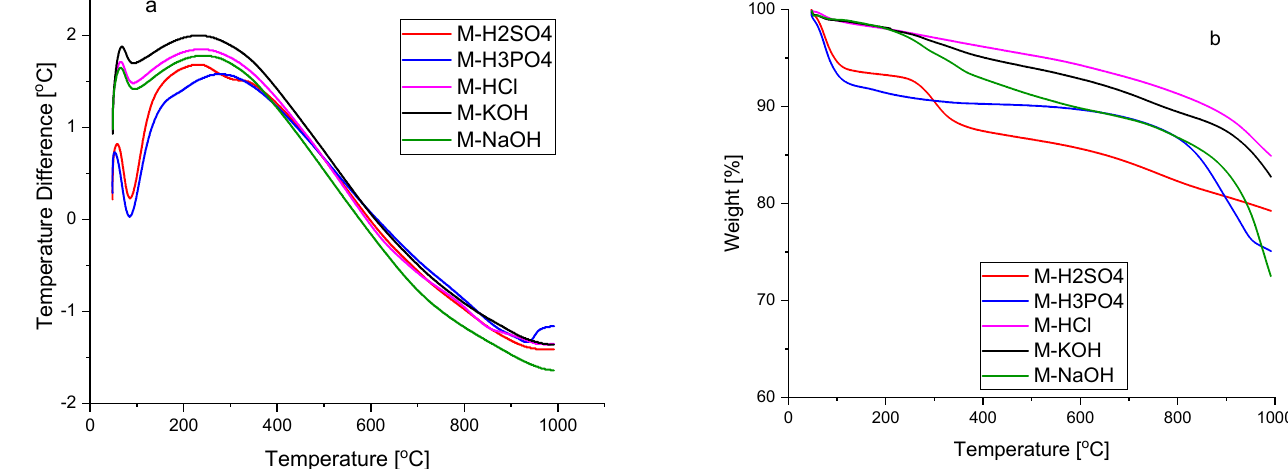
Figure 2. The DTA ( a ) and TG curves ( b ) of the activated carbons produced from molasses. SEM pictures of the activated carbons revealed the textures of the obtained materials On the DTA curve of the M-H2SO4 sample, apart from the effect, which is associated (Figures 3 and S3). The surface of activated carbon produced using bases looked as if they with the evaporation of adsorbed water, a second small endothermic effect with the be- were made of corrugated petals. The surface of activated carbon produced by means of ginning of approx. 250 °C was recorded. The second degree of weight loss is associated acids looked different. The picture showed a more massive, yet undulating surface. with this effect. At a temperature of 400 °C, the total weight loss is 20.5% by weight. This weight loss may be related to the removal of absorbed sulphur oxides associated with the use of concentrated sulphuric acid [23]. The presence of sulphur groups was shown in the FTIR spectrum (Figure 1b).